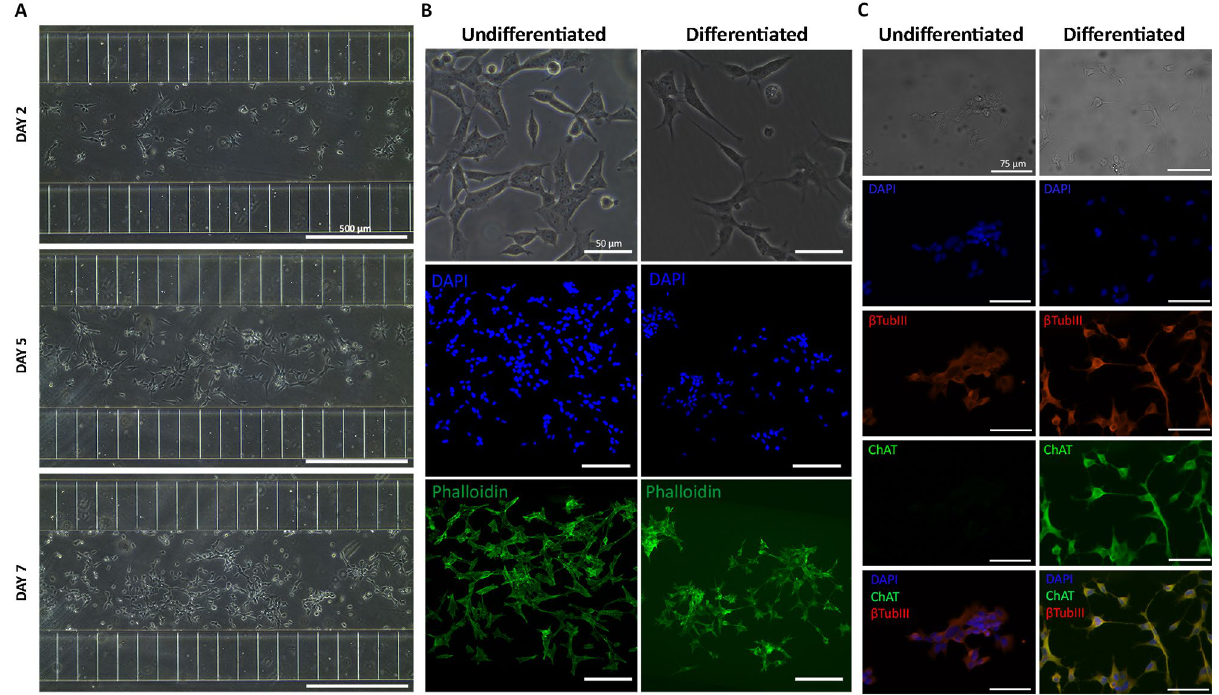
Figure 6. Differentiation of SH-SY5Y cells in microfluidic device in flow condition. ( A ) Phase contrast images of SH-SY5Y under differentiation at day2, day5 and day7 of incubation with phase 2 medium . Scale bar 500 µm. ( B ) Phase contrast and fluorescent (DAPI/phalloidin) images of undifferentiated SH-SY5Y cells and differentiated cells after 7 days of incubation. Differentiated SH-SY5Y became morphologically more similar to primary neurons with a more pyramidal shaped cell body and long and numerous but randomly distributed processes. Scale bar: 50 µm. ( C ) Fluorescent images of βtubIII/ChAT stained undifferentiated and differentiated SH-SY5Y cells. Scale bar: 75